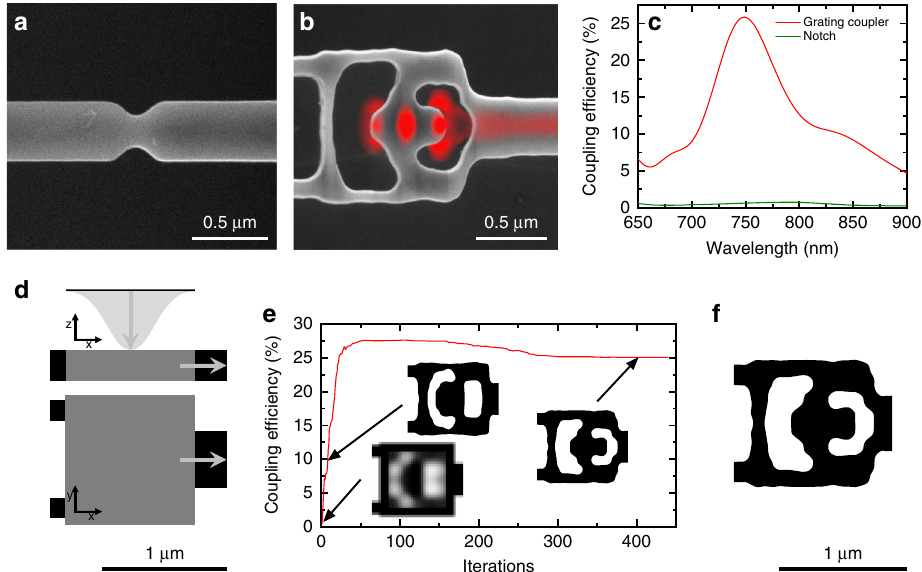
Fig. 1 Inverse design of ef fi cient nanophotonic interfaces. Scanning electron micrograph of a a notch and b an inverse-designed vertical coupler with simulated fi elds superimposed in red. c Simulated performance of the vertical coupler (red) and the notch (green). d Design set-up, where the gray area indicates the design area. e In-coupling ef fi ciency during design optimization; insets illustrate different optimization phases. The small performance drop beyond 200 iterations of optimization occurs when fabrication constraints are imposed. f Final device design after